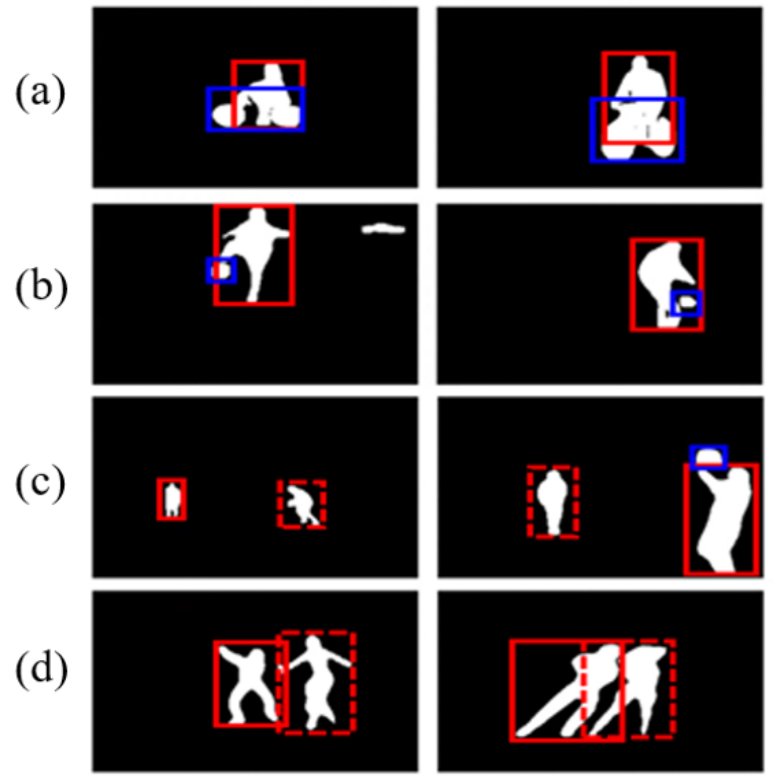
Figure 4. Details about pairwise stream inputs; images of each row are from the same video in different timelines. Solid red line boxes represent the “actors” in the action. Dotted red line boxes represent the “person” who is regarded as an “object”. Solid blue line boxes represent the “object” of “actors”. ( a ) “Biking”. ( b ) “SoccerJugglings”. ( c ) “Basketball”. ( d ) “IceDancing”.